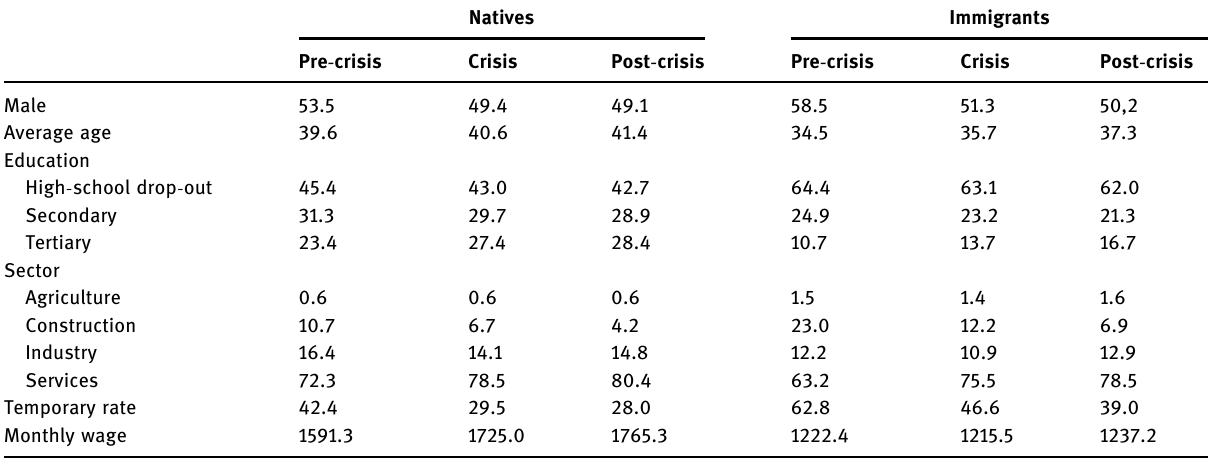
Table A4: Immigrants and natives characteristics